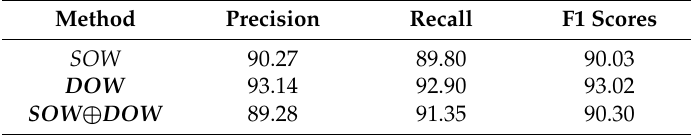
Table 8. Results of un-normalized representation of sentence vectors on SemEval-2015